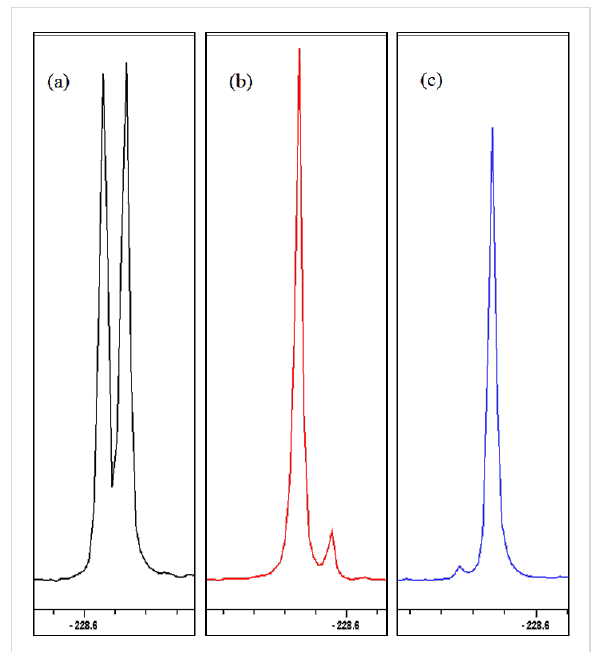
Figure 4: Partial 19 F{ 1 H} NMR spectra (376 MHz, L-(+)-DIPT/CDCl 3 , 300 K) spectra of (a) racemate 28c , (b) diol 28b and (c) 28a under standard acquisition parameters revealing the partial enantiomer overlap.